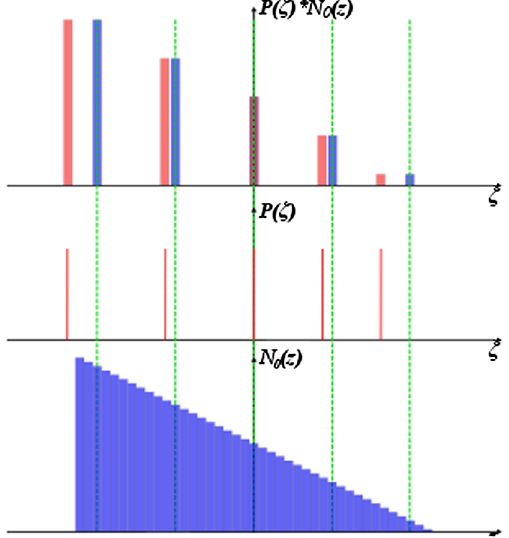
FIG. 13. The x 2 0 -series perturbation. Bottom: The ideal n 0 ð z i f Þ profile. Middle: The perturbation function P ð ζ Þ at various positions alongthebunch.Top:Slicesoftheidealprofile n 0 ð z i f Þ (blue)andthe perturbed profile n 0 ð z i f Þ (red). The shift, ζ depends on z i f . Particles move to the back of the bunch and its distance is proportional to the square of the distance from the center of the